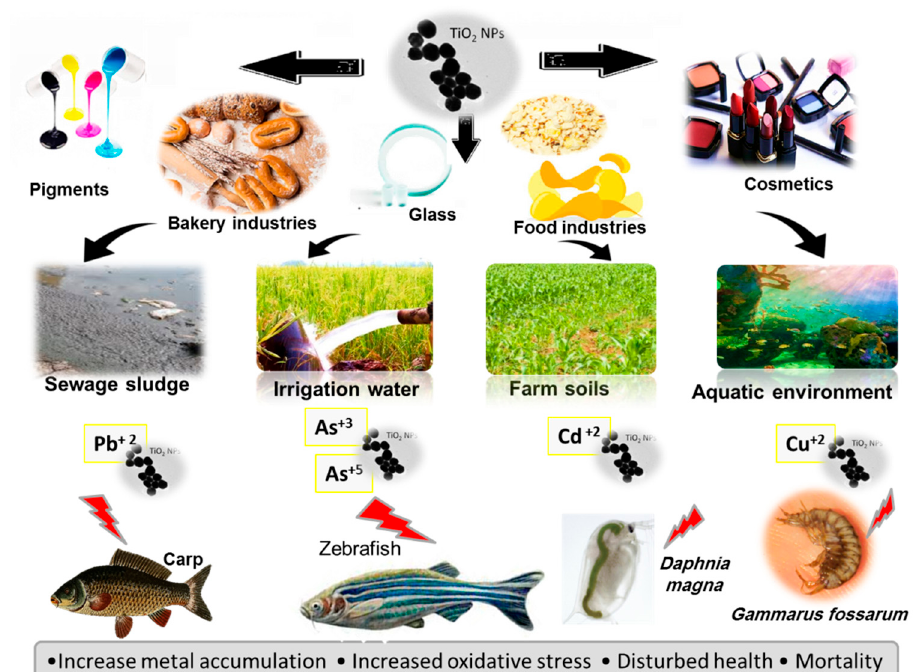
Figure 1. Sources of titanium dioxide nanoparticles exposure, possible interactions with heavy metals, and negative effects on different organisms.